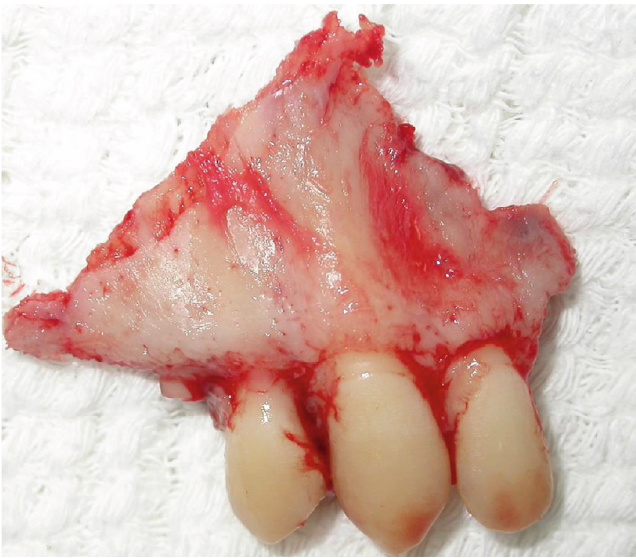
Figure 2: Alveolar fragment after removal of granulation tissue brought between it and the maxilla.